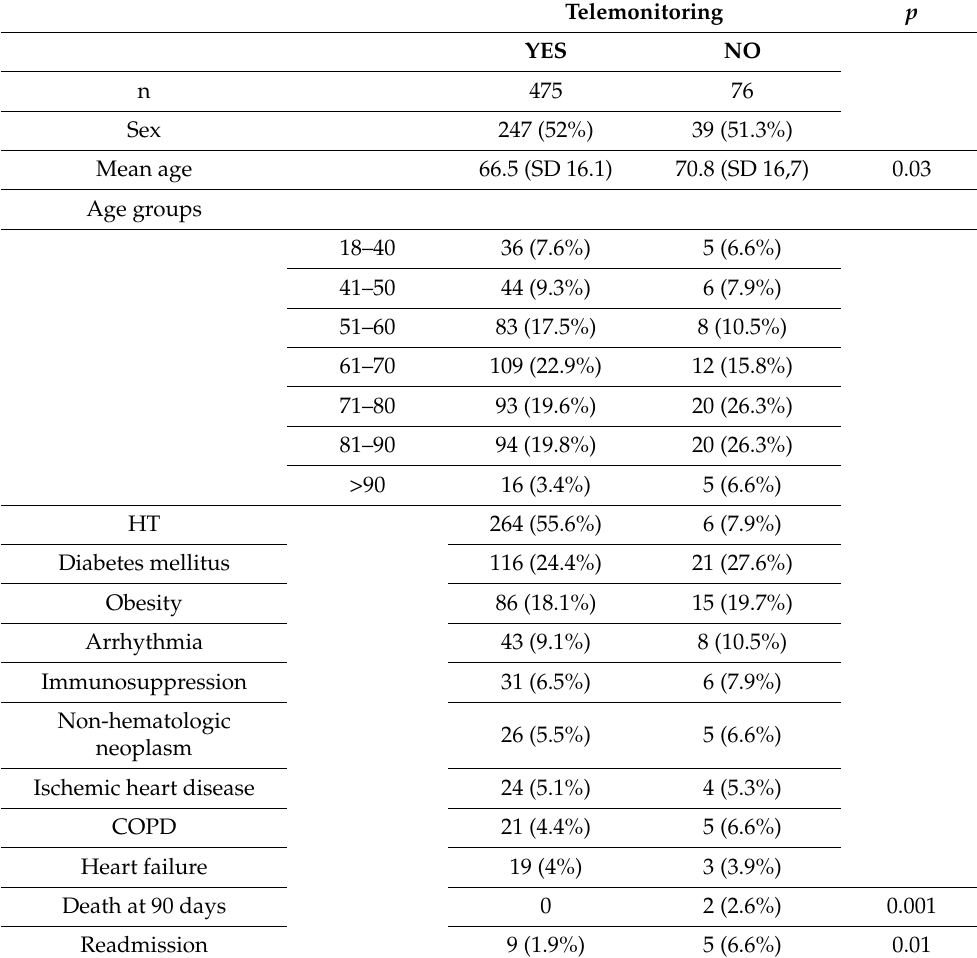
Table 4. Characteristics of patients discharged in